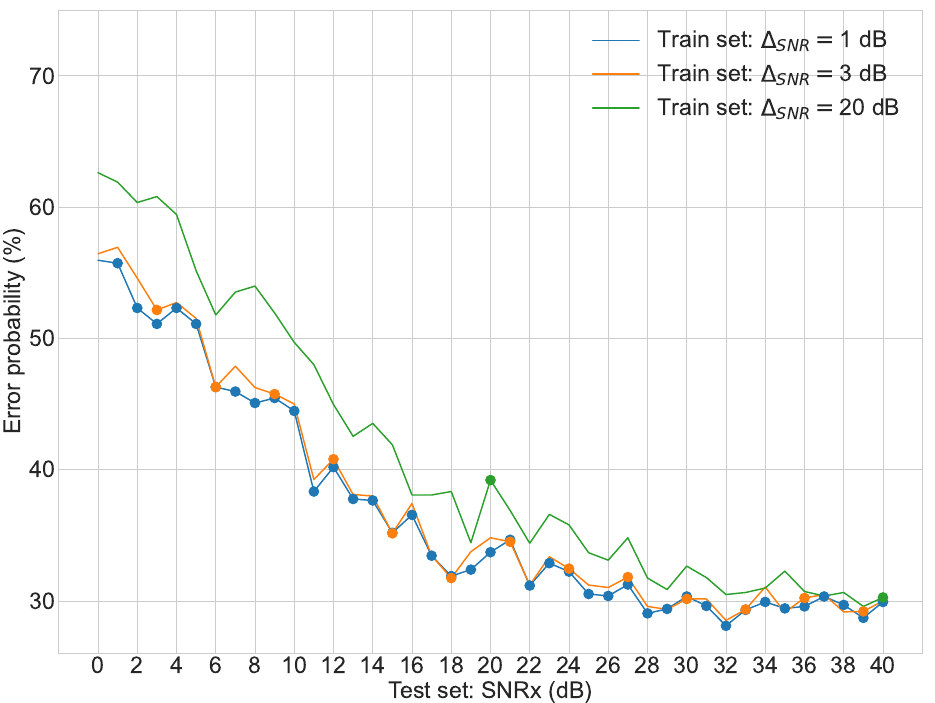
Figure 4. Second stage experiment results: test sets error probabilities for three different models (Real-World Noise Scenario).